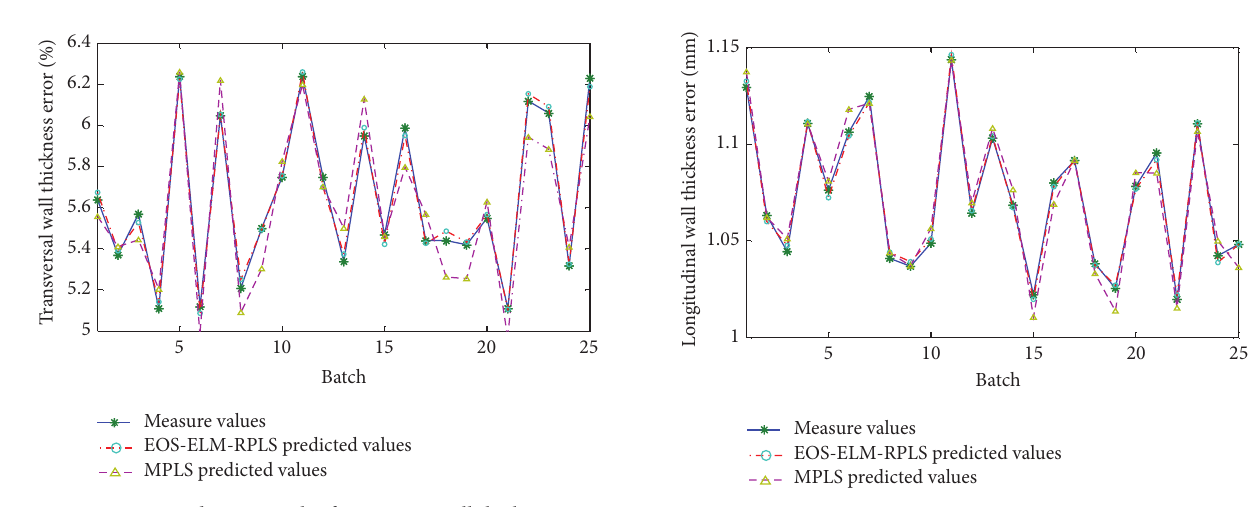
Figure 4: Prediction result of transverse wall thickness. Figure 5: Prediction result of longitudinal wall